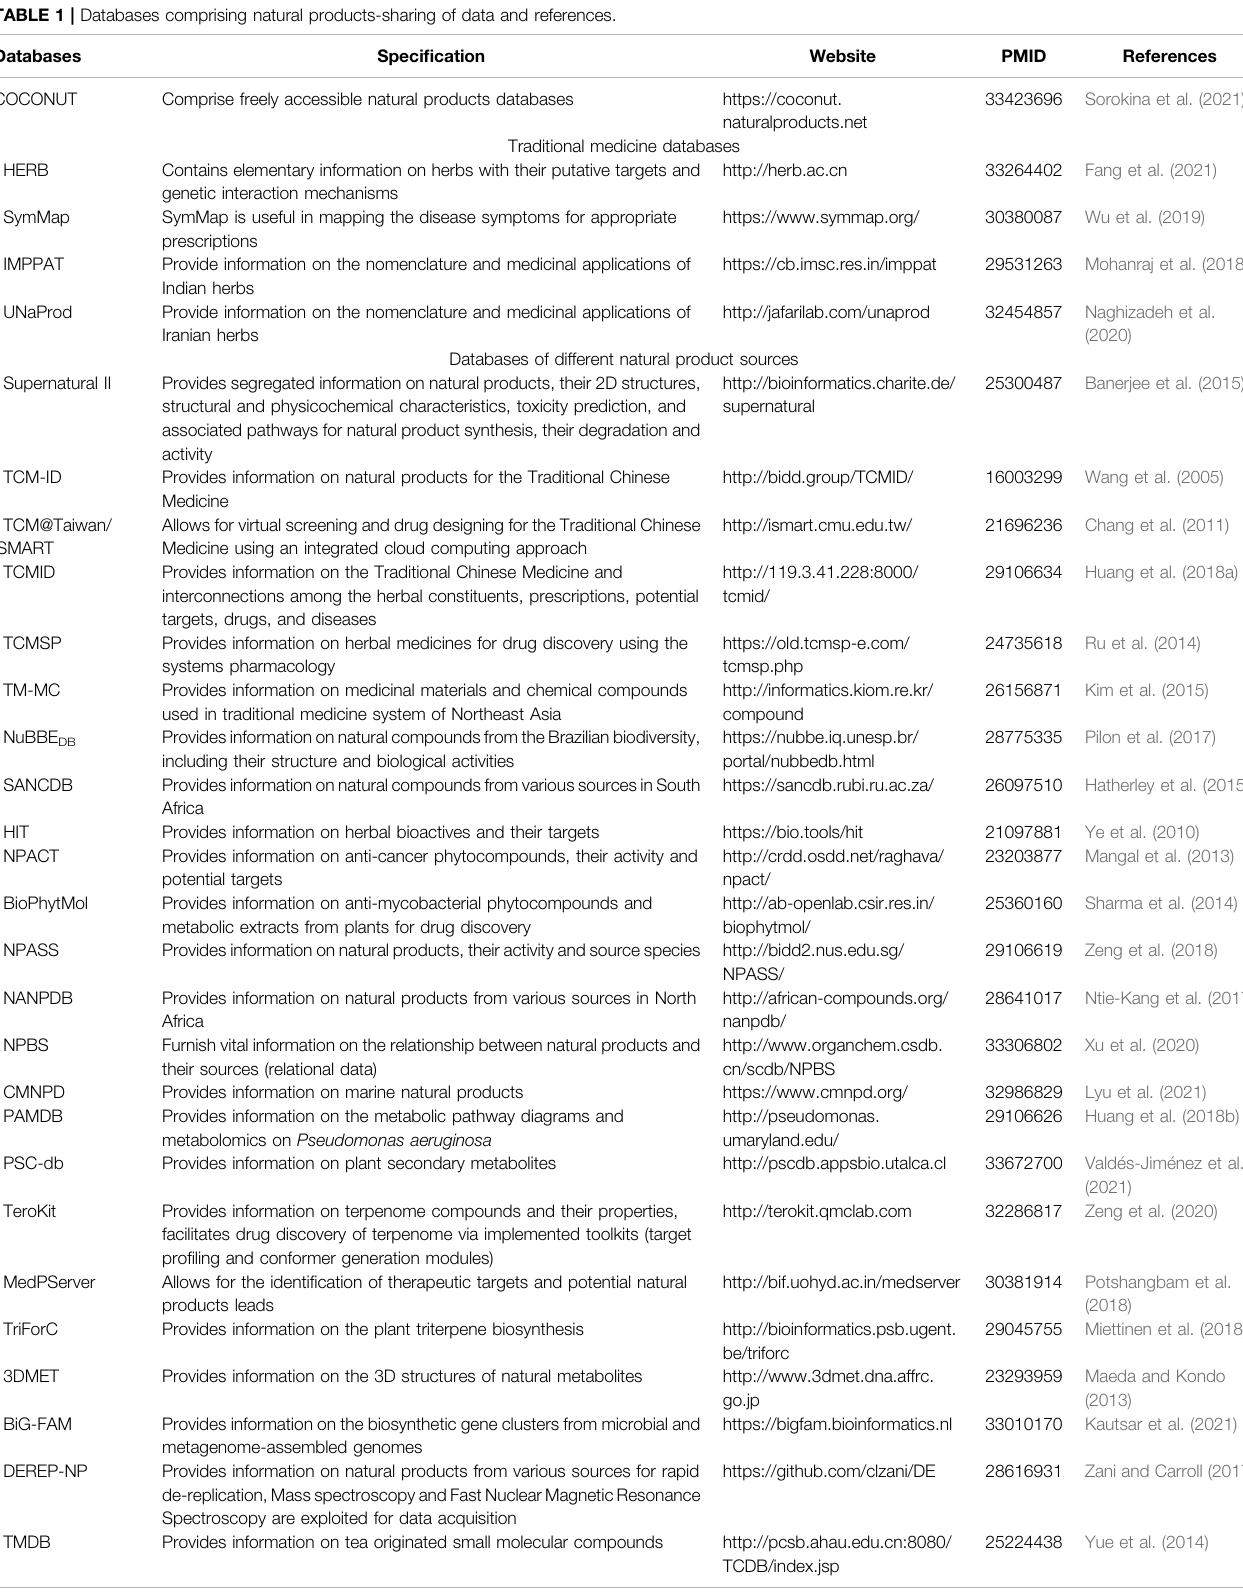
TABLE 1 | Databases comprising natural products-sharing of data and